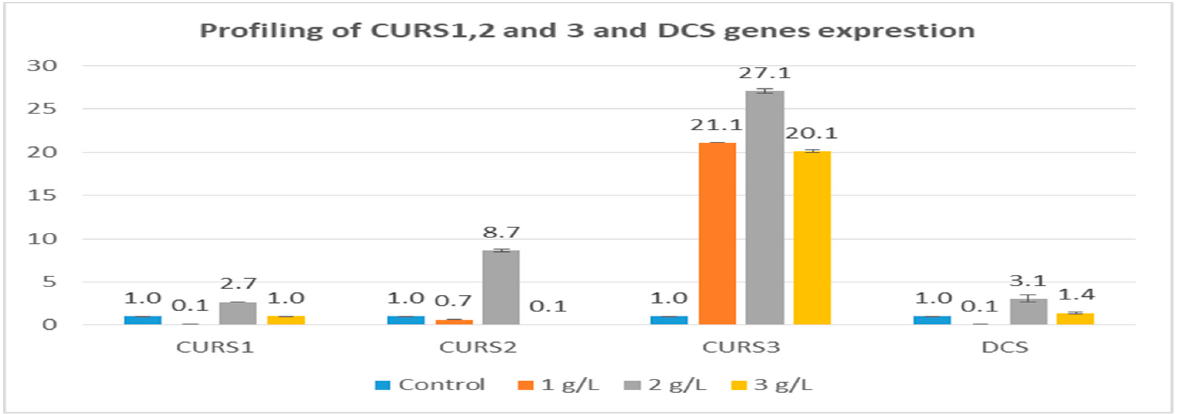
Figure 2. Differential expression profiling of curcuminoid synthase genes, CURS-1, CURS-2, CURS- 3 and DCS, in C. longa rhizomes from control and SAE (1, 2 and 3 g/L)-treated plants. The CUR-1, -2 and -3 as well as DCS gene expressions were [26] The CURS-1, -2, -3 and DCS genes in SAE (1, 2